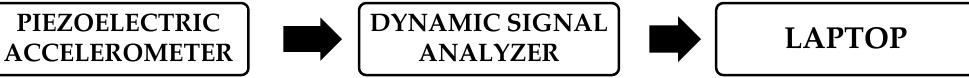
Figure 2. Block diagram of proposed system architecture.